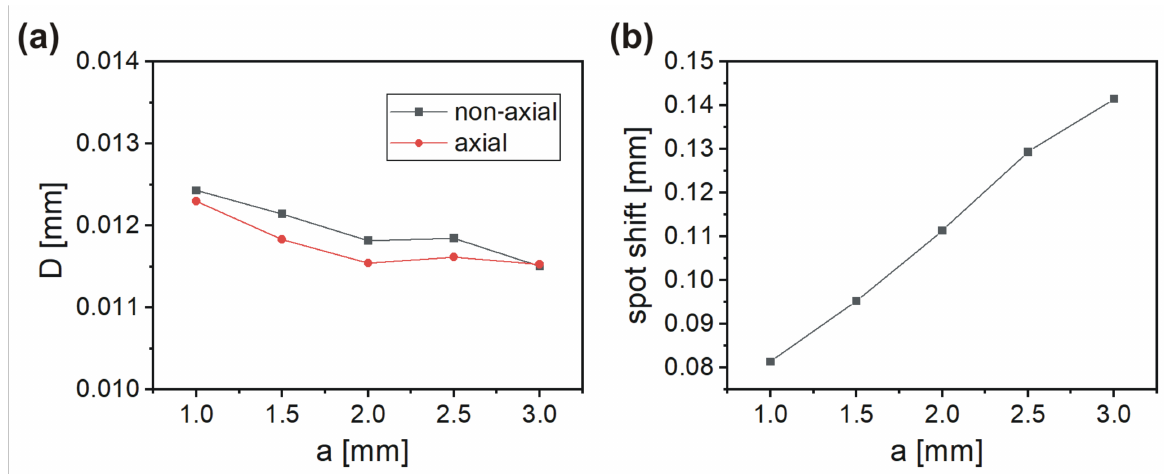
Figure 15. Results of non-axial microcolumn experiment: ( a ) electron beam size as a function of the Einzel lens size; ( b ) electron beam spot shift as a function of Einzel lens